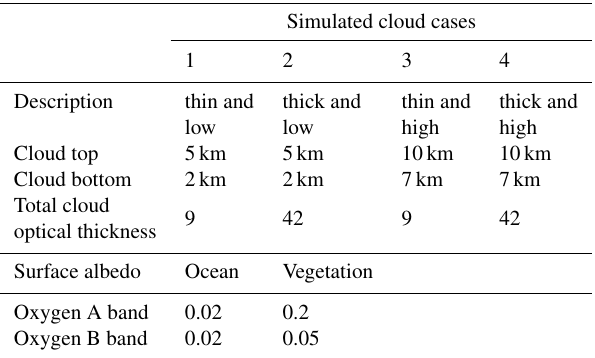
Table 1. Parameters for the four cloud cases used in the retrieval